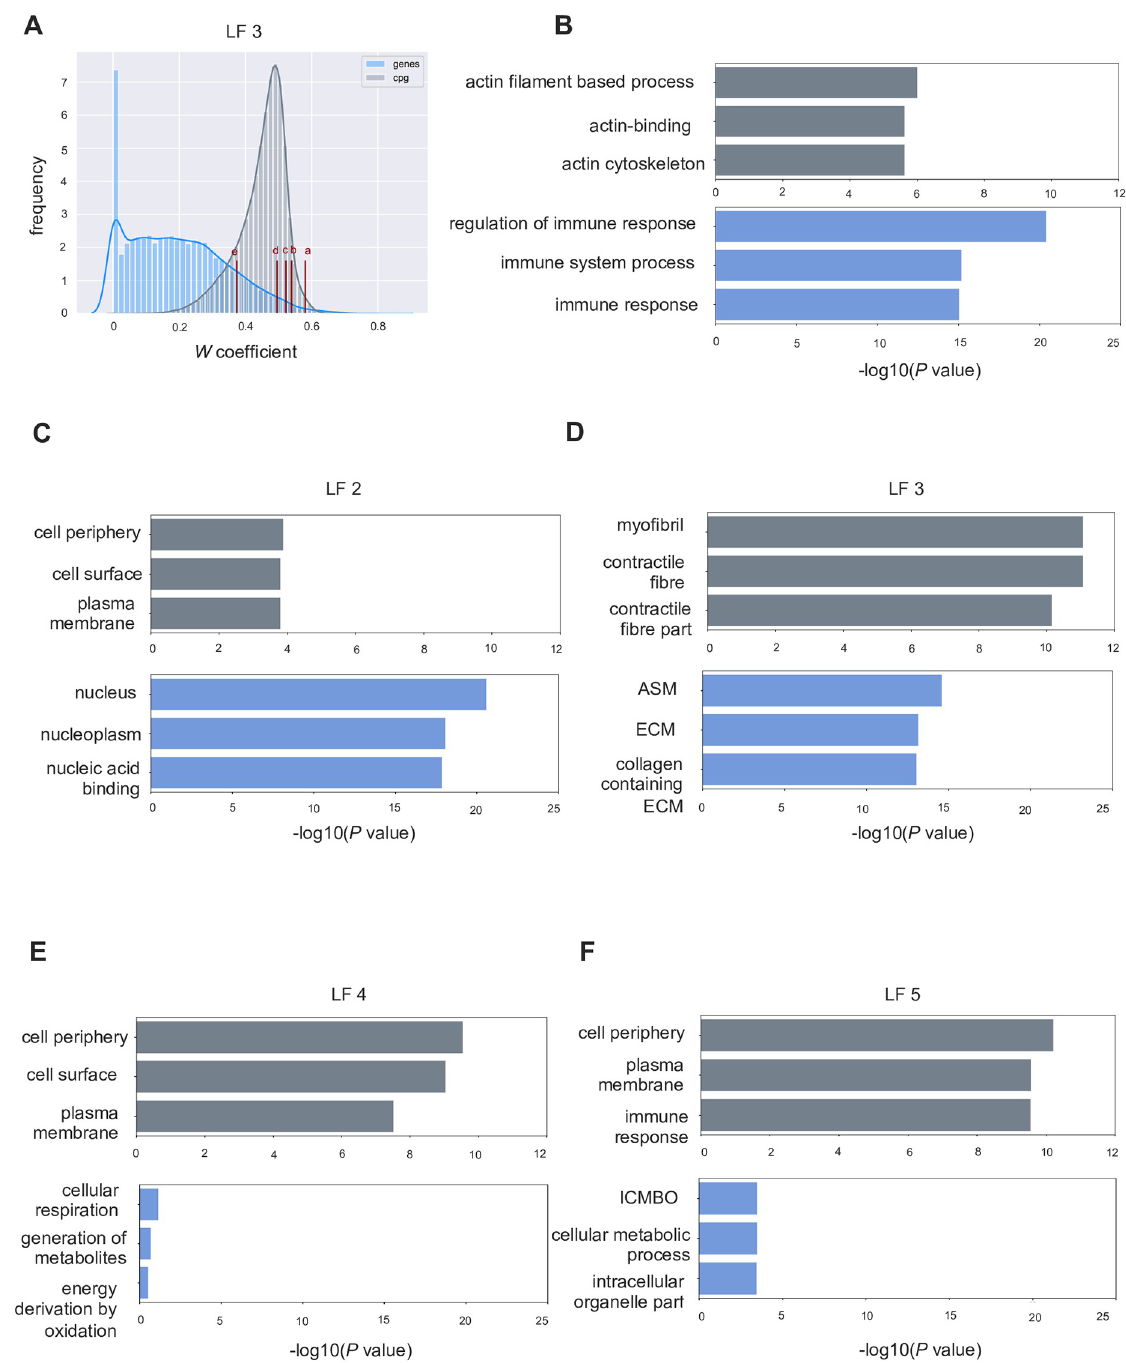
Fig 3. Distribution of W matrix coefficient and top gene ontology terms. A) The distribution plot of the W coefficients for gene and CpG features for latent factor 3. The labels a-e represent the 99 th , 95 th , 90 th , 75 th and 25 th quantiles. B-F) Bar plots representing the log 10 P value of significance of enrichment for a gene ontology term. For the selected features from each latent factor, ( > 90 th percentile), a GO terms analysis performed for gene and methylation features and the FDR corrected P for significance of the term is reported. ASM = anatomical structure morphogenesis, ECM = extra-cellular matrix, ICMBO = intracellular membrane-bounded organelle.